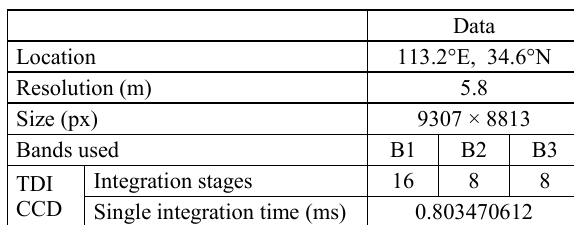
Table 2. Description of the experimental data ZY-3 satellite is equipped with 5.8-m optical cameras, capable of recording images in four spectral bands: blue (B1), green (B2), red (B3), and infrared (B4). The B1, B2, and B3 bands